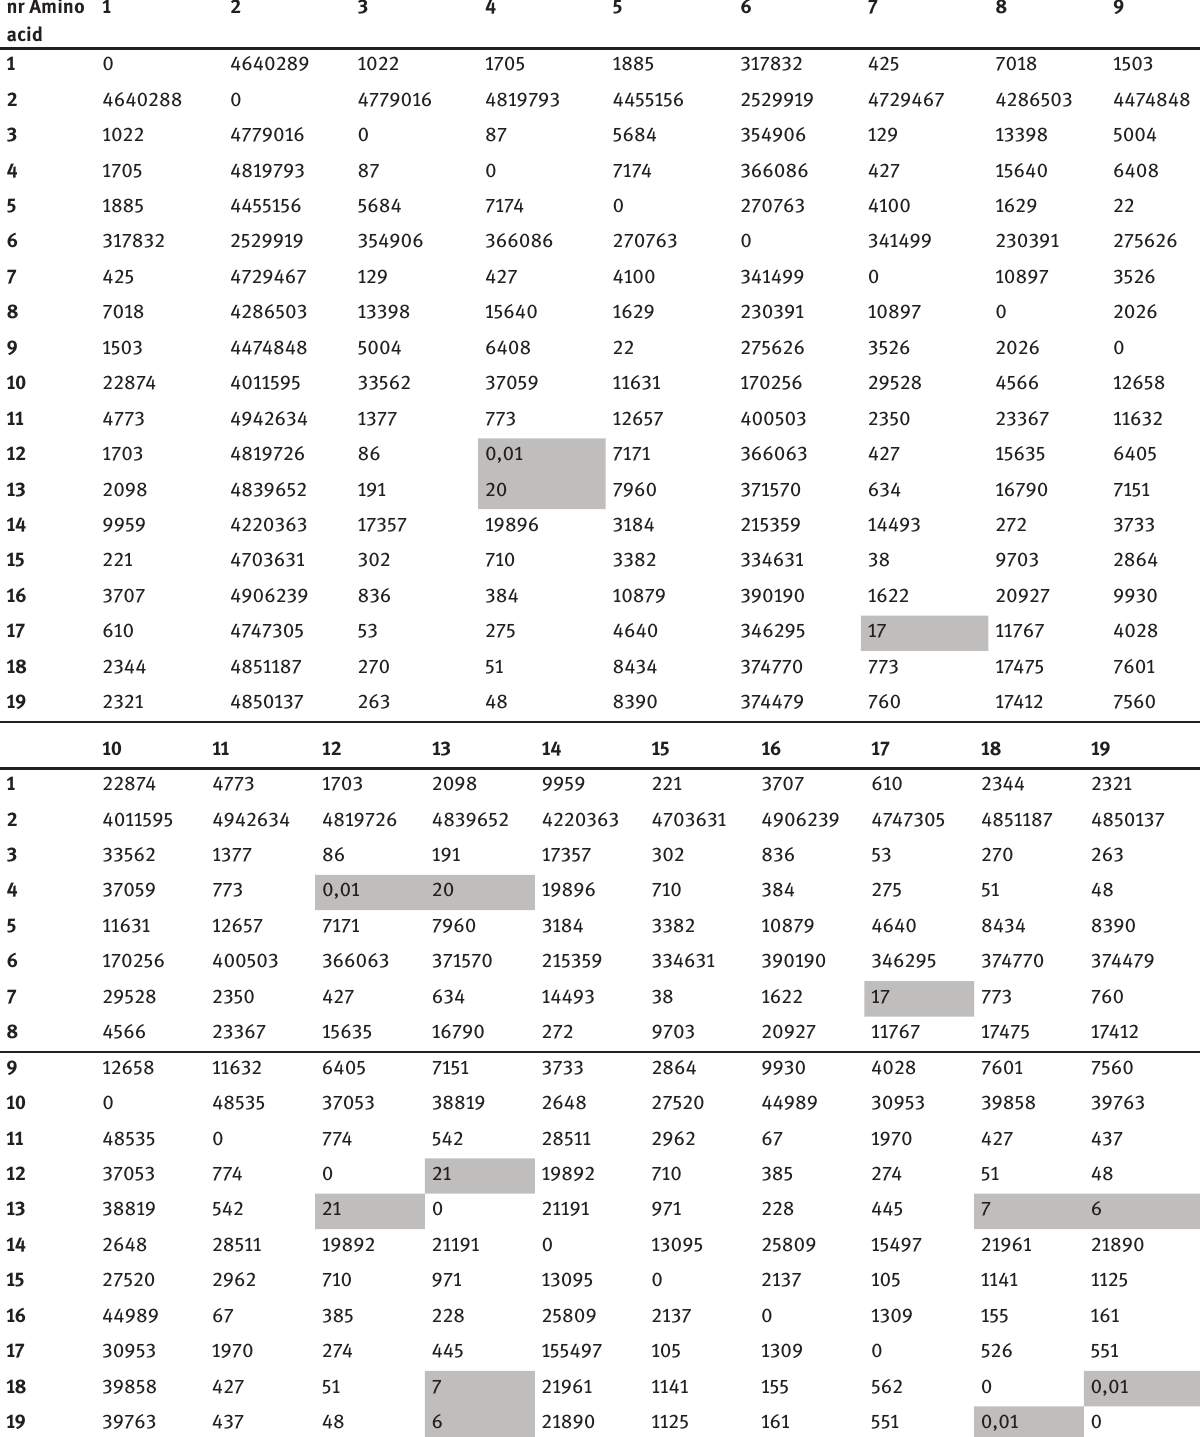
Table 5: Squared Mahalanobis distances between free amino acids in two environment. nr Amino